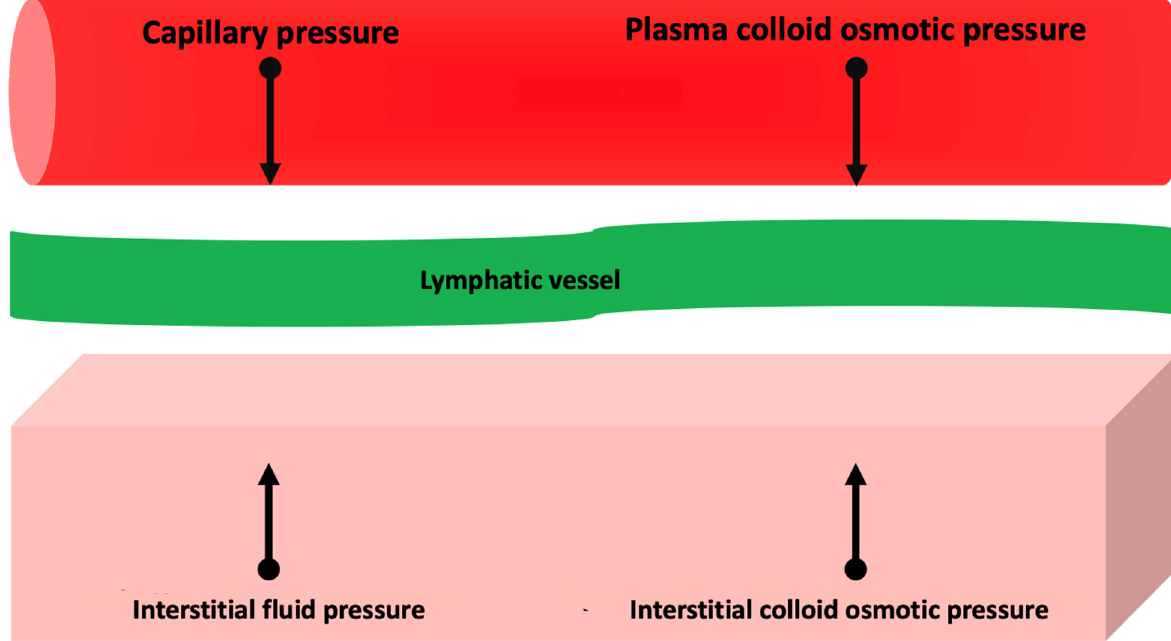
Figure 1. Pathophysiology of interstitial edema. See text for further